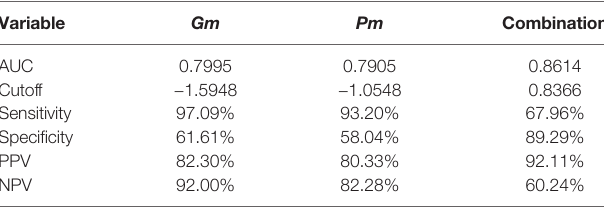
TABLE 1 | Performance of Gm and Pm alone and in combination with other bacteria for the diagnosis of colorectal cancer in cohort I.